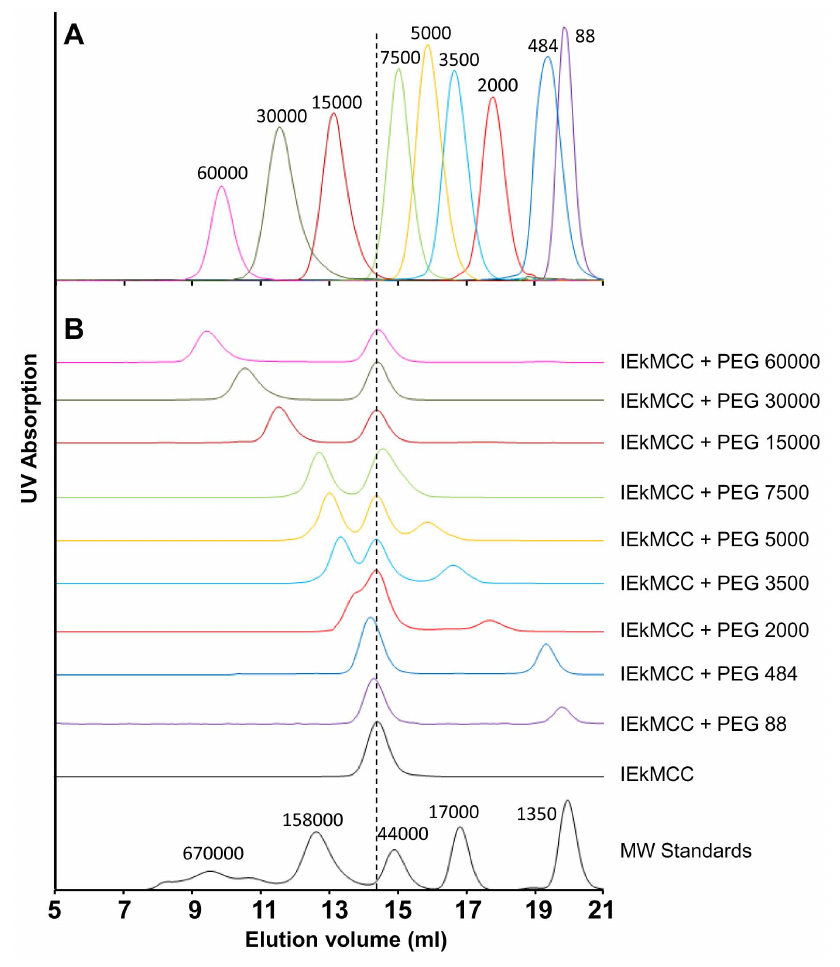
Figure 2. Characterization and separation of PEG polymer linkers and IEkMCC-PEG conjugates. (A) Compiled elution curves of nine PEG polymer linkers from a Superdex 200 10/300 GL gel filtration column. The polymers were detected through the weak UV absorption of the biotin group using a 245 nm UV detector. (B) Separation of the IEkMCC and PEG polymer reaction products. The reaction products were loaded on a Superdex 200 10/300 GL gel filtration column to separate IEkMCC-PEG conjugates, unreacted IEkMCC, and unreacted PEG polymers. The reaction products of PEG 15000, PEG 30000 and PEG 60000 were first purified with an IEk-binding affinity column to eliminate unreacted PEG polymers. The dotted vertical line indicates the elution volume of IEkMCC protein. The late elution peaks of unreacted polymers can be seen for PEGs ranging from PEG 88 to PEG 5000. In reaction with PEG 7500, unreacted IEkMCC and unreacted polymer formed a single peak that was eluted at a position between unconjugated IEkMCC and pure PEG 7500.